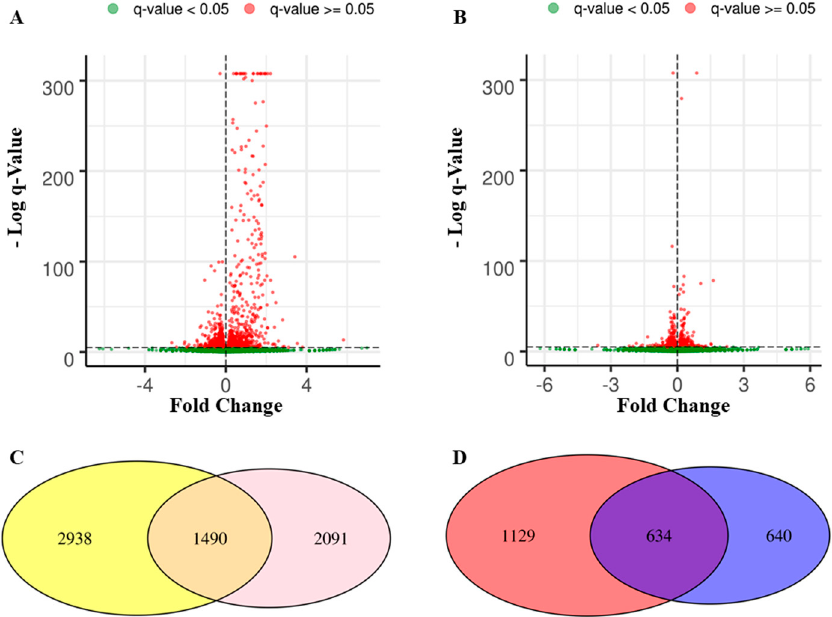
Figure 1. DEGs distribution among control, A β 1-42 , and A β 1-42 -MOR/ α -CD. The distribution of the genes in the comparison of control against A β 1-42 groups is represented in the volcano Plot on the left ( A ) while the panel ( B ) shows the gene distribution for the comparison A β 1-42 against A β 1-42 -MOR/ α -CD groups. At the bottom, section ( C ) highlighted the DEGs in the two analyses. There are 2938 DEGs in the first analysis that were not deregulated in the second analysis (left yellow panel) and 2091 DEGs in the second analysis that were not included in the first one (right pink panel). In addition, 1490 genes were deregulated in both the analysis. Section ( D ) shows 1129 DEGs upregulated in the first analysis that were not downregulated in the second one ( left red panel ) and the 640 DEGs downregulated in the second analysis that were not upregulated in the first one ( right blue panel ). The 634 DEGs simultaneously upregulated in the first analysis and downregulated in the second one (central panel) are the focus of this study. Table 1. Differentially expressed genes exclusively enriched in “Cellular Death”, “Cellular Repair” and “Autophagy” groups simultaneously.